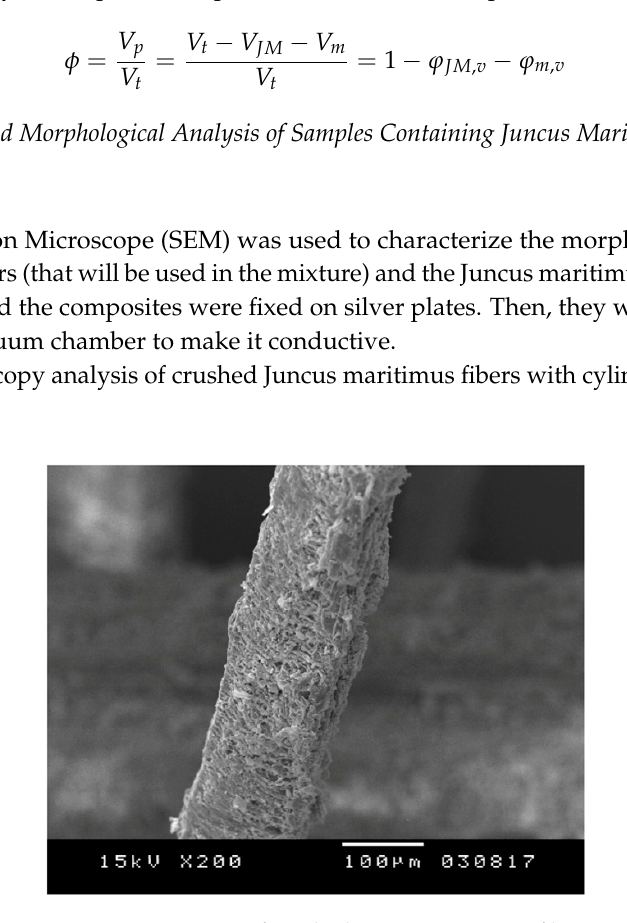
( b ) Figure 4. Scanning electron microscopy images: ( a ) Reference mortar (without fibers); ( b ) Juncus maritimus/mortar composites.